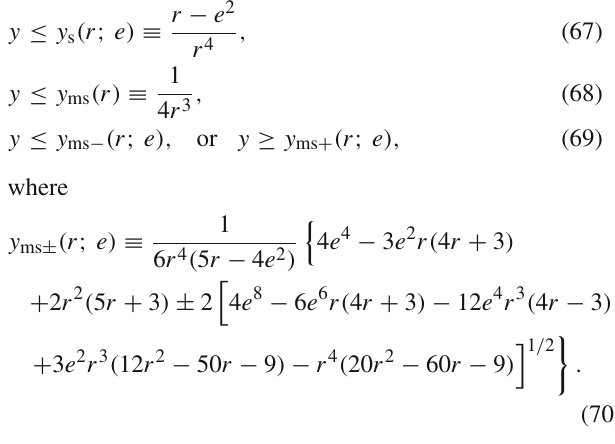
( ± ) ( r ; y , e ) are real, ms ( 1 , 2 )